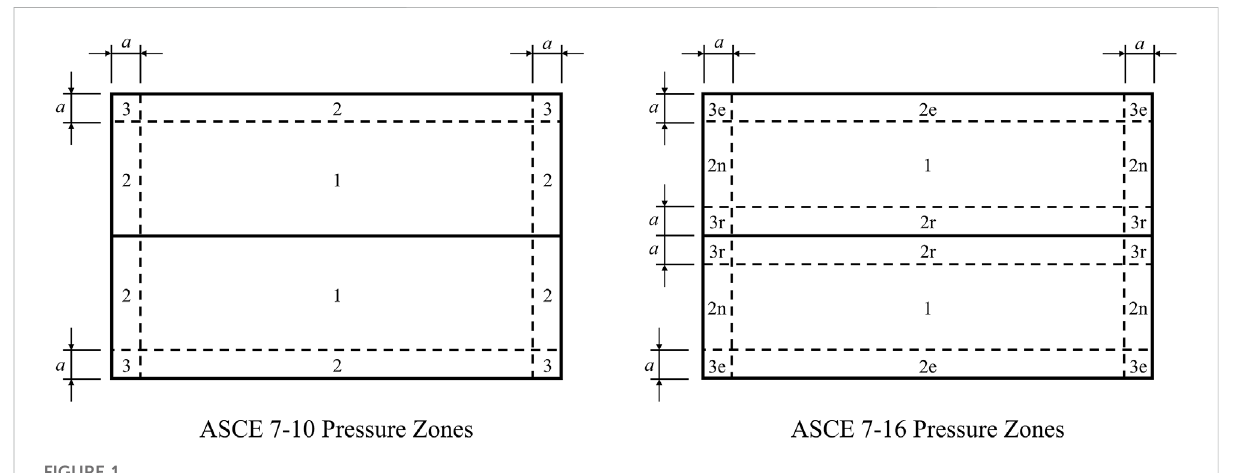
FIGURE 1 Maps of wind pressure zones for ASCE 7 – 10 and ASCE 7 –